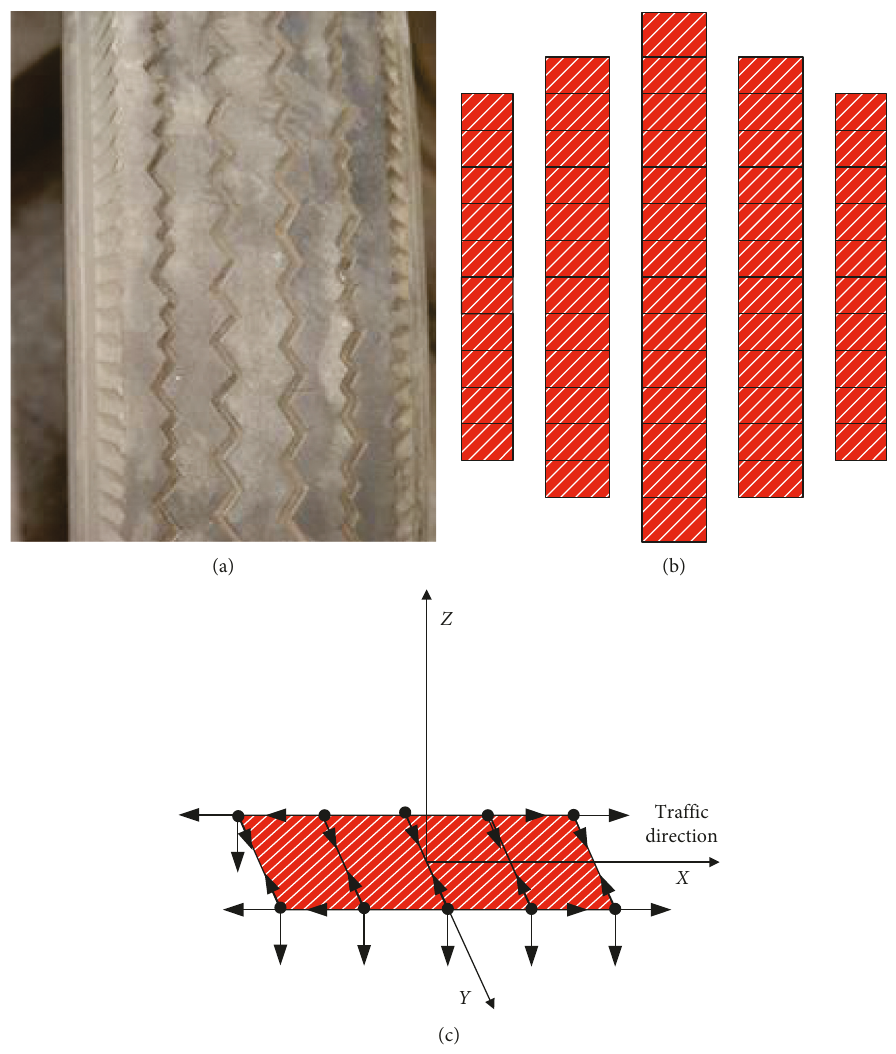
Figure 2: Tire-pavement contact area: (a) longitudinal tread pattern tire; (b) simplified tire-pavement contact area for the 3D-FE model; (c) vertical and horizontal TPCP directions acting on the nodes of part mesh